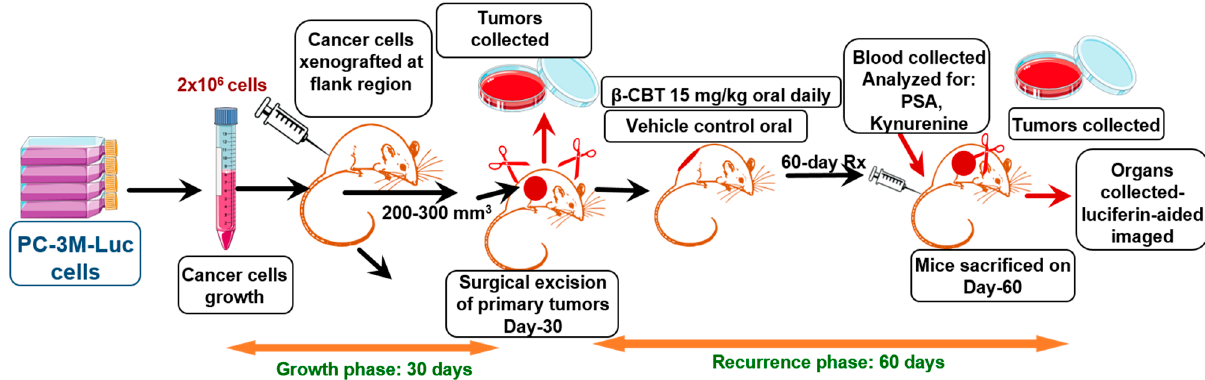
Figure 5. Overview of the animal study experiment.